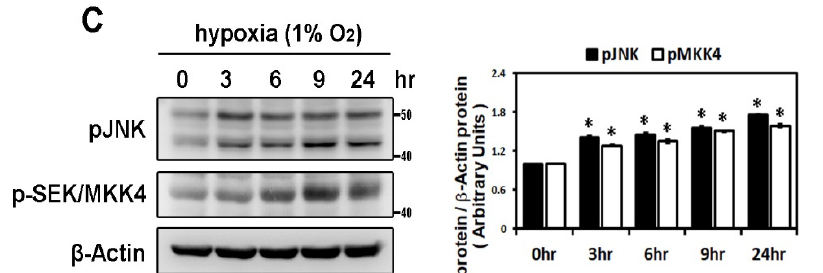
Figure 2. Panel A : Effect of MAPK inhibitors on the expression of hypoxia-induced HIF-1 α and profibrotic proteins. Whole cell lysates of HL-1 cells pre-incubated with SB203580 (10 − 5 M), U0126 (10 − 5 M), SP600125 (10 − 5 M) or DMSO as a vehicle for 30 min, then treated with hypoxia stress (1% O 2 ) for 6 h, were analyzed by Western blots to determine the levels of HIF-1 α and fibrosis-related proteins (COL1A, COL3A, TGF- β 1, α -SMA) expression. The bar graph shows the value of each sample relative to that of control cells that received vehicle only. The data are mean ± SEM ( n = 4 per group, * p < 0.05 vs. control; # p < 0.05 vs. hypoxia) from four independent experiments. Panel B : Effect of hypoxic treatment on phosphorylated JNK signals. Representative Western blots and protein levels of JNK, phosphorylated JNK and SEK/MKK4 in HL-1 cells treated with hypoxia (1% O 2 ) or CoCl 2 (10 − 4 M) for 6 h. Panel C : Exposure of cultured HL-1 cells to hypoxia (1% O 2 ) for the indicated times resulted in time-dependently increased protein levels of phosphorylated JNK and SEK/MKK4. The data are mean ± SEM ( n = 4 per group, * p < 0.05 vs. control) from four independent experiments.